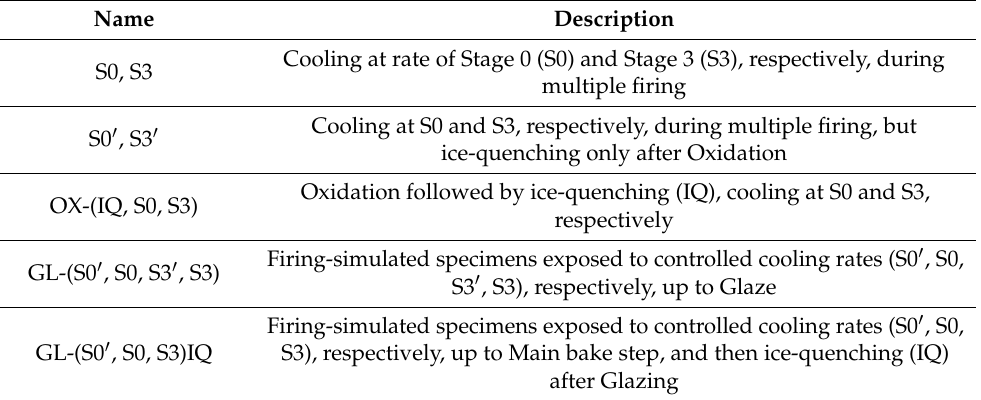
Table 4. List of sample